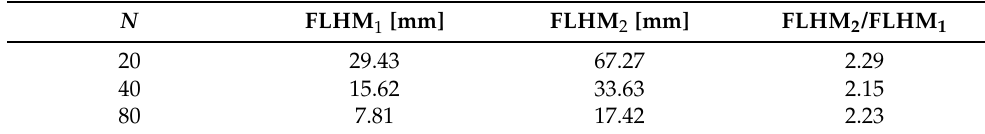
Figure 6. Bifocal ZP focusing profiles vs. axial coordinate. Red dashed line: N = 40. Blue solid line: ( a ) N = 20 and ( b ) N = 80. Insets depict the ZP layouts for N = 20 (top) and N = 80 (bottom). ( c ) FLHM at the first (blue) and second (red) focus against N . Table 1. FLHM values for Figure